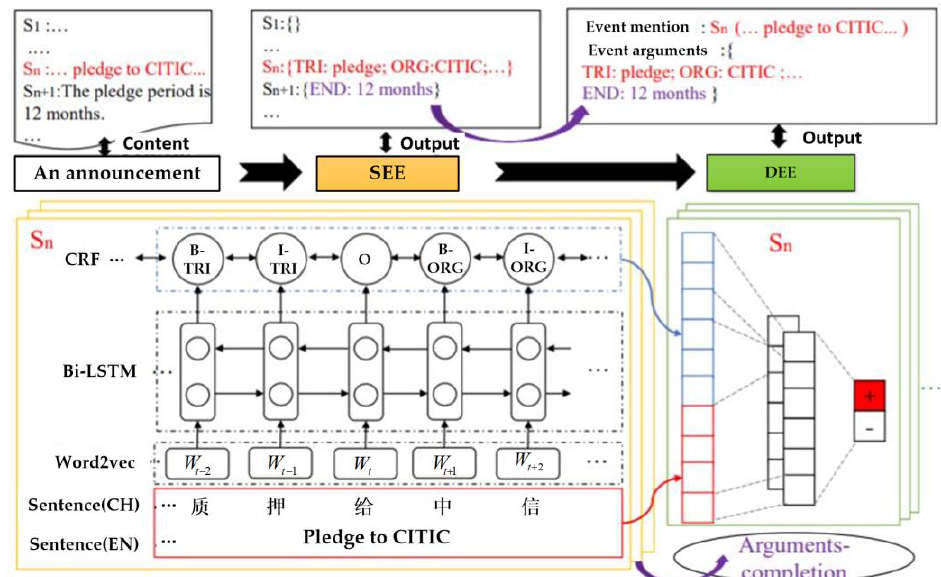
Figure 9. The Architecture of DCFEE, which was designed to divide the event-extraction sentence-level extraction and document-level extraction into two parts process into sentence-level extraction and document-level extraction into two parts [87].